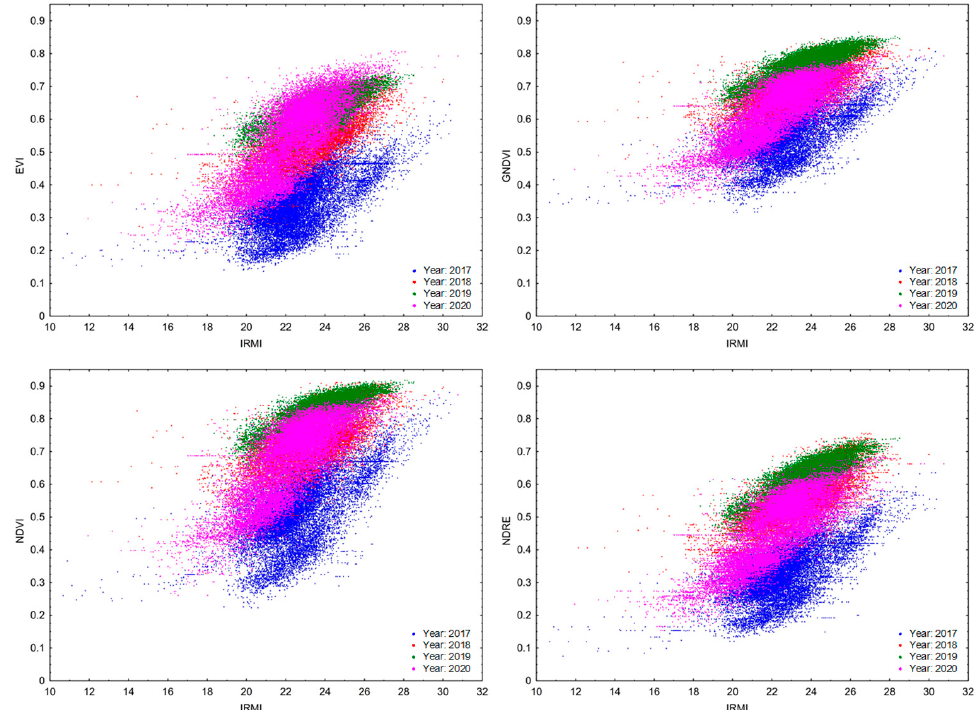
Figure 6. Spearman’s rank correlation coefficient and scatter graph showing the correlation between the IRMI vegetation index and the vegetation indices of EVI, GNDVI, NDRE and NDVI in the respective experimental years.